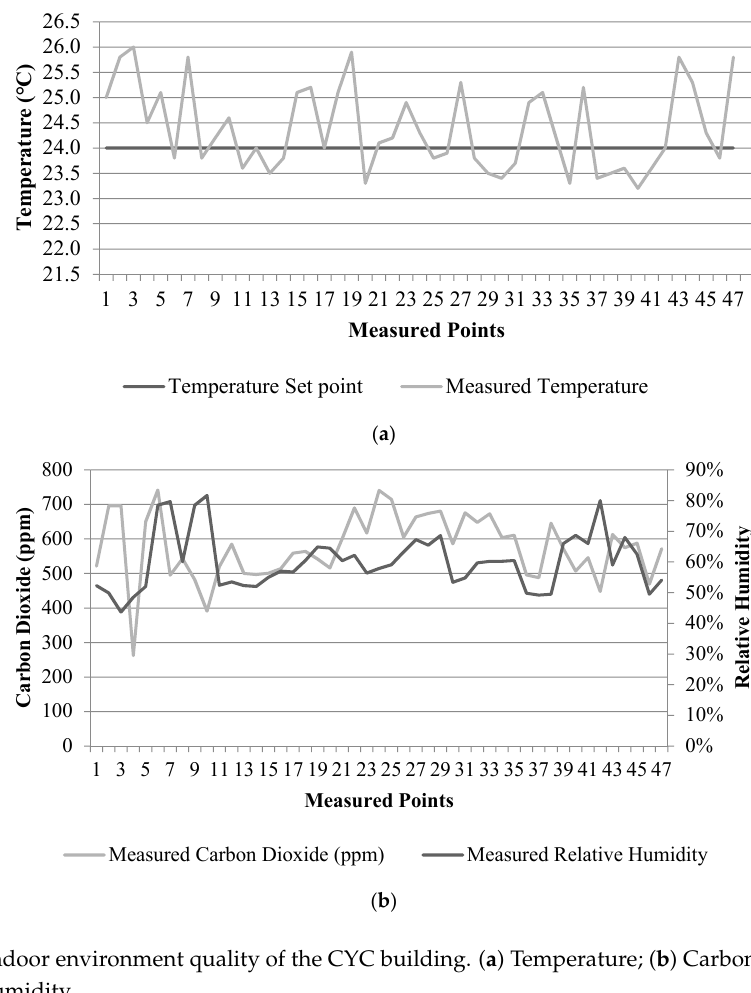
Figure 3. Indoor environment quality of the CYC building. ( a ) Temperature; ( b ) Carbon Dioxide and Relative Humidity.